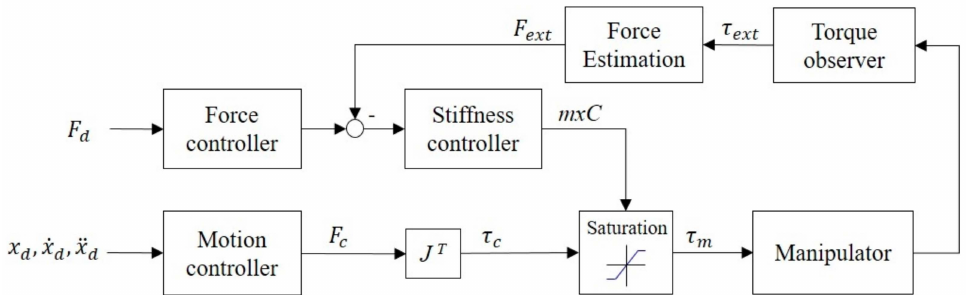
Figure 10. Real-time sti ff ness control diagram.